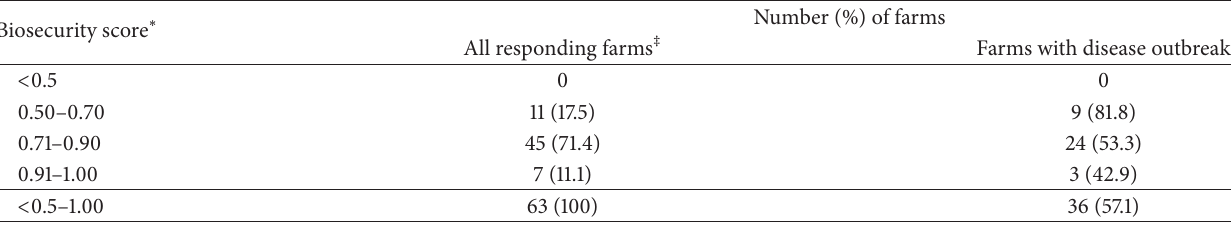
Table 4: Number (%) of farms with various scores on biosecurity in relation to occurrence of disease outbreak # .